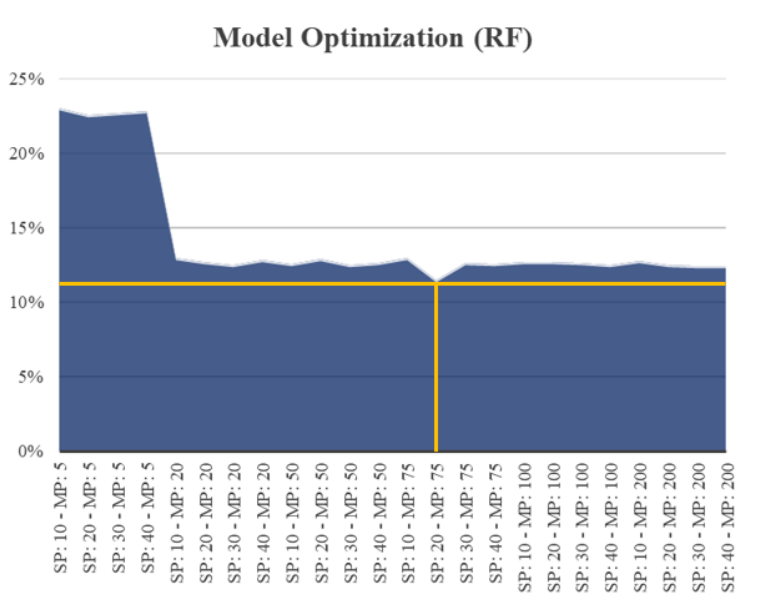
Figure 18. Categorical feature importance for the best-performing models (with spatial variables) for PVs. Figure 19 shows the six most important features that contributed to the model’s out- put for total PVs for the model with spatial variables. The number of lanes (which reflects the capacity of the road in the studied location) had 51.95%, indicating the most important influence on the PV prediction model. The Euclidean geometry, related to the spatial var- iables, achieved 14.93% and was the second most important feature (The percentage on the y -axis shows the feature importance score for the variables).